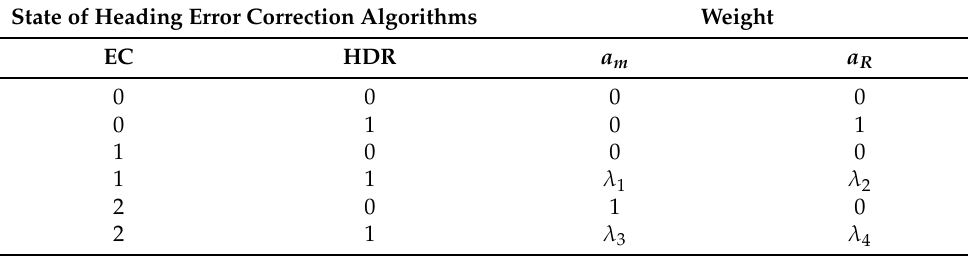
Table 1. Weights of the heading error measurements for electronic compass (EC) and heuristic drift reduction (HDR)